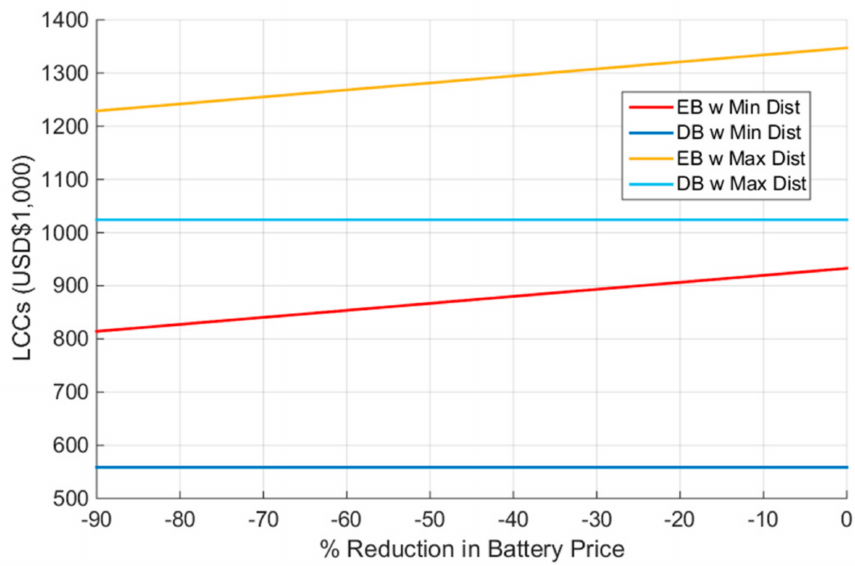
Figure 8. Effect of the reduction in battery prices on the life-cycle costs of electric and diesel buses.